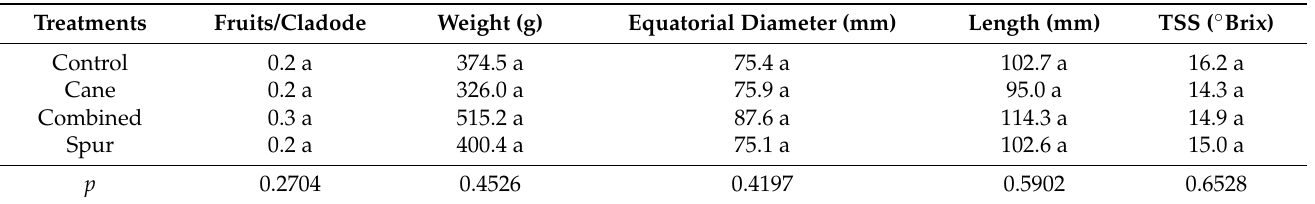
Table 5. Fruit production per cladode and fruit characteristics as an average in the last harvest in response to different pruning